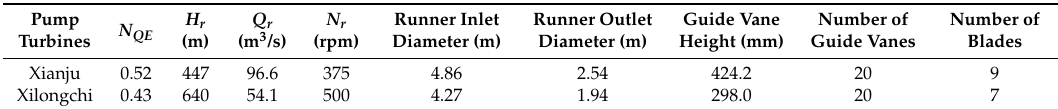
Table 3. Basic design parameters of